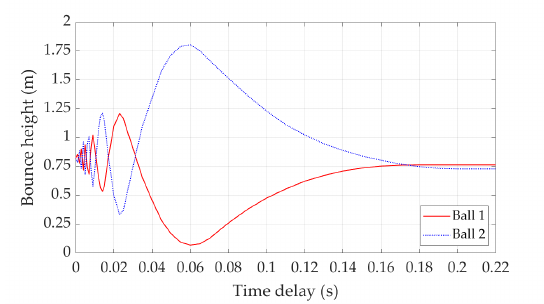
Figure 10. Bounce height of balls with different release time delay.